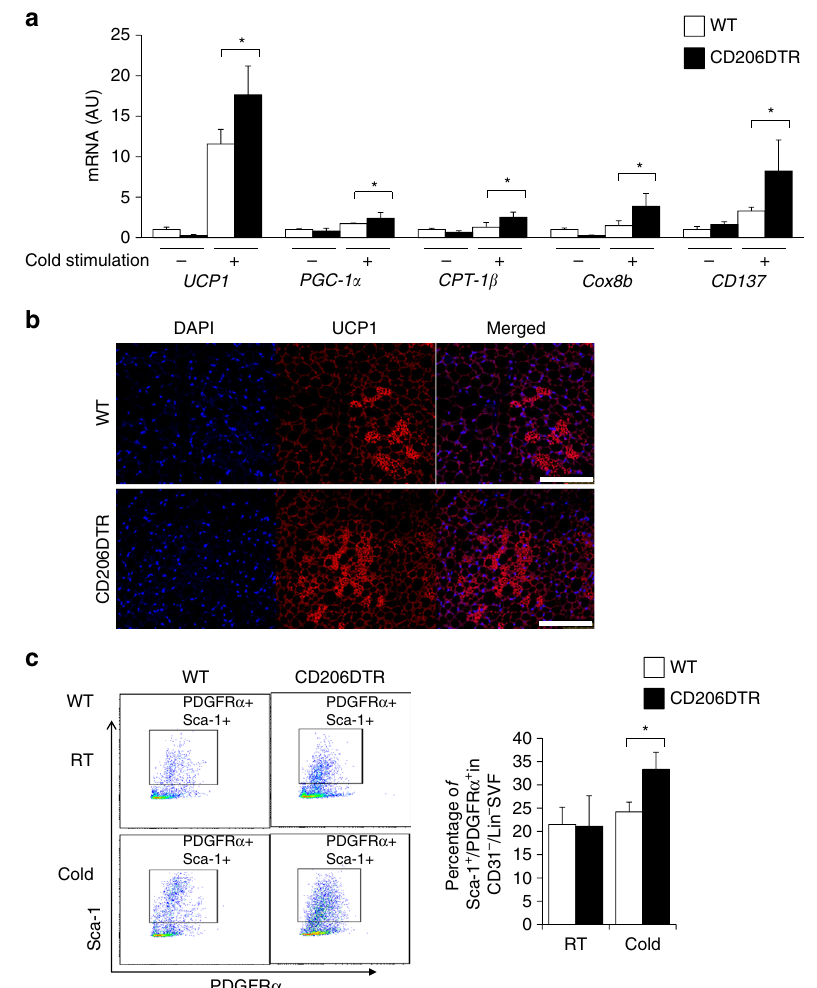
Fig. 10 Depletion of CD206 + M2-like macrophages promote browning of iWAT. a Relative mRNA expression of UCP1, PGC-1 α . CPT-1 β and CD137 levels in iWAT after CD206 + cells depletion under cold exposure ( n = 3 – 5 mice per group). b Immunostaining of paraf fi n section of eWAT stained with anti-UCP1 antibody in DT-treated CD206DTR mice after cold exposure compared with WT control. The images were taken with a Leica TCS-SP5 (40×). c Representative fl ow cytometry analysis of PDGFR α /Sca-1 double positive cells from iWAT of DT-treated CD206DTR and WT mice at RT and cold stimulated (25 °C and 6 °C) (left panel). The percentage of Lin( − )APs positive fraction in the DT-treated CD206DTR mice are shown in the right panel ( n = 3 – 5). For this, fi rst, negative selection of PE-Cy7 anti CD31 (endothelial), FITC anti-mouse lineage cocktail were selected followed by positive selection of PE anti-PDGFR α and APC-Cy7 anti Sca-1. Full gating strategy is given in Supplementary Fig. 13b.The data are shown as the means ± SEM. * P < 0.05 compared with littermates by Student ’ s t